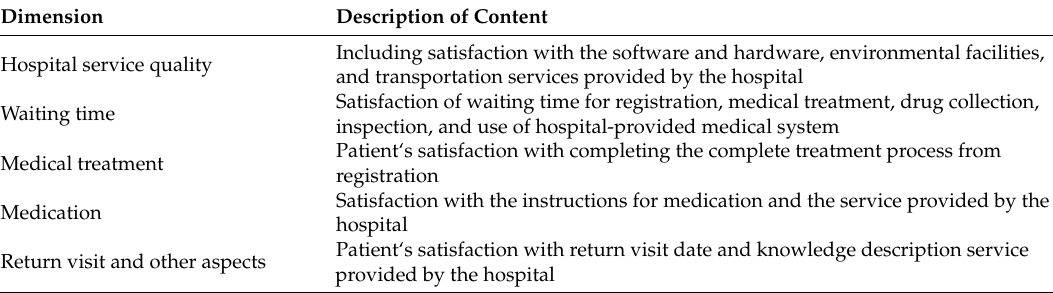
Table 2. Satisfaction